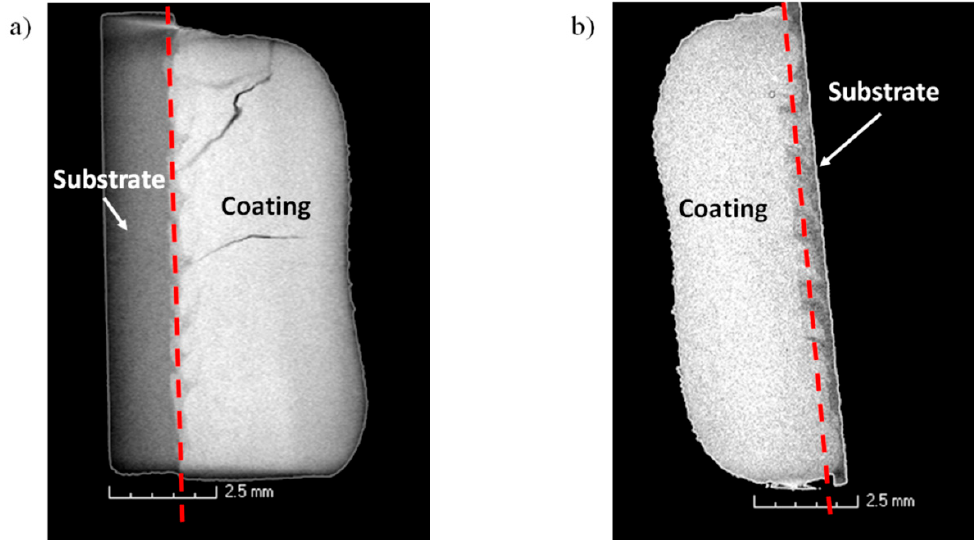
Figure 3. Microfocus X-ray computer tomography image of the LENS-fabricated samples: ( a ) nr 2 and ( b ) nr 18.